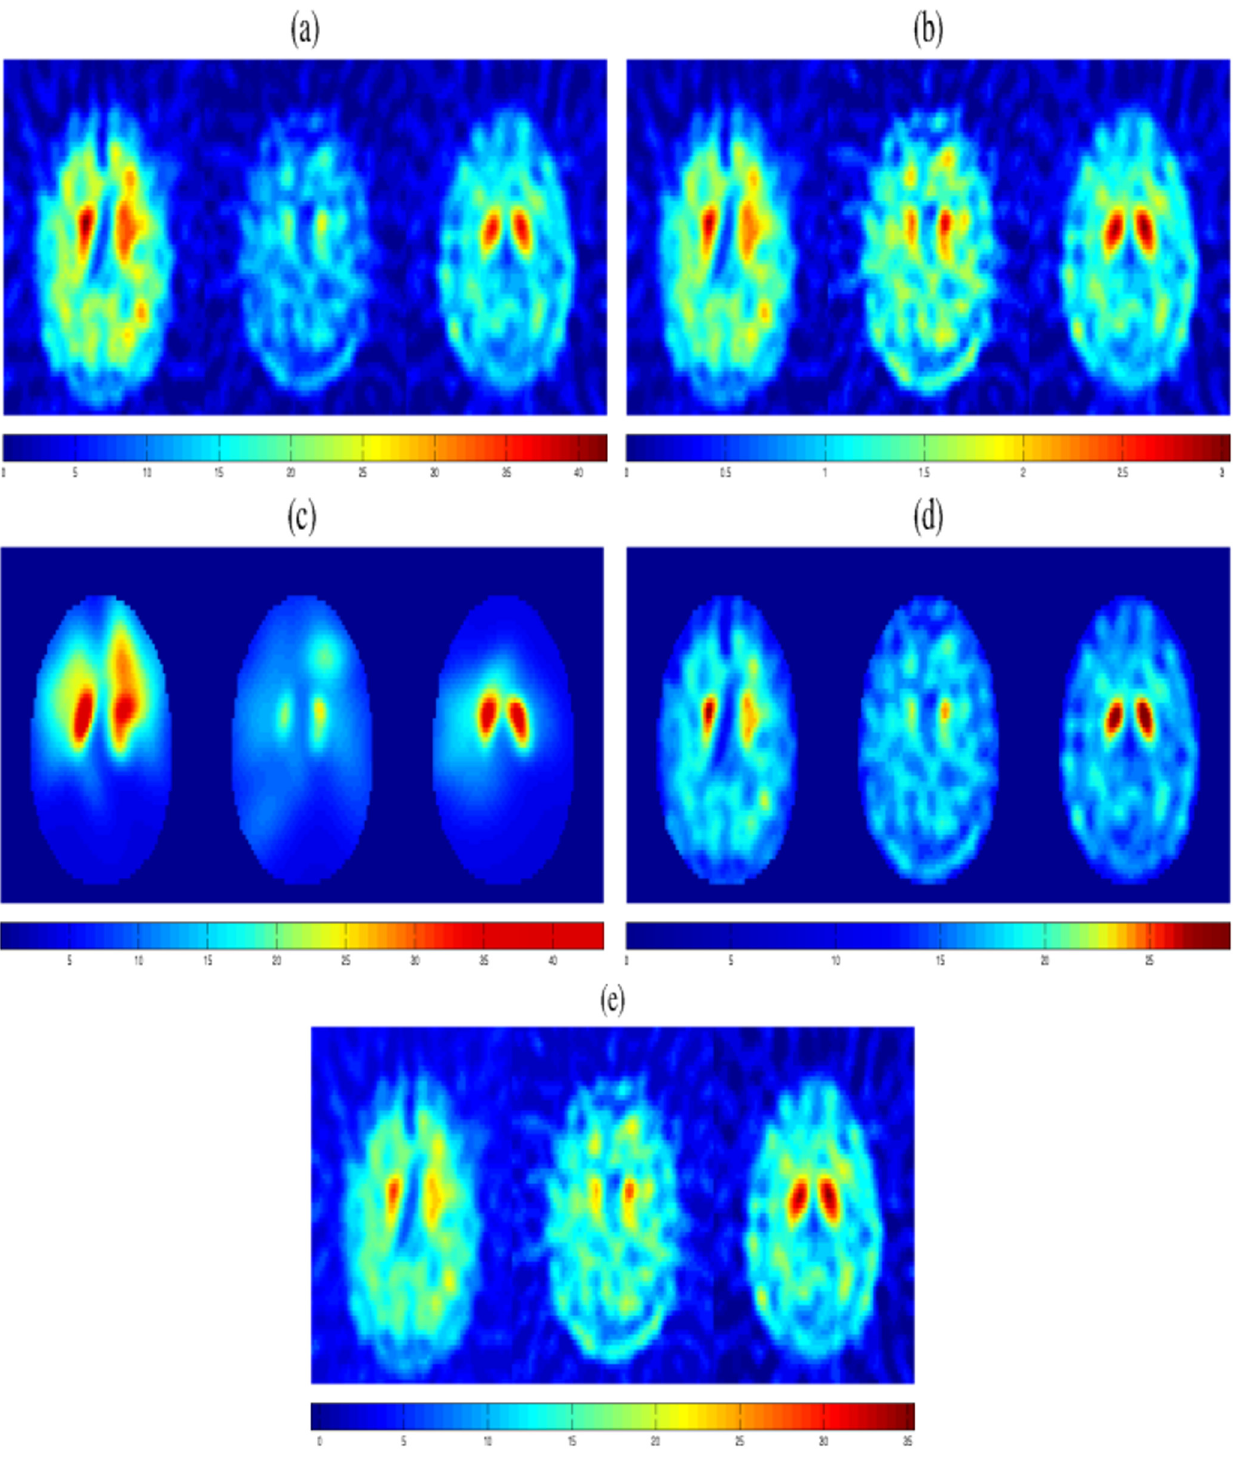
Fig 4. A given transaxial slices of 3 selected brain images before and after intensity normalization. (a) original DaTSCAN images from the database (Raw data), (b) normalized brain images by specific-to-non-specific ratio approach (BR all images), (c) normalized brain images by filtering by means of GMM approach (FGMM images), (d) normalized brain images by MSE approach (MSE images) and (e) normalized brain images by α -stable approach ( α -stable images).